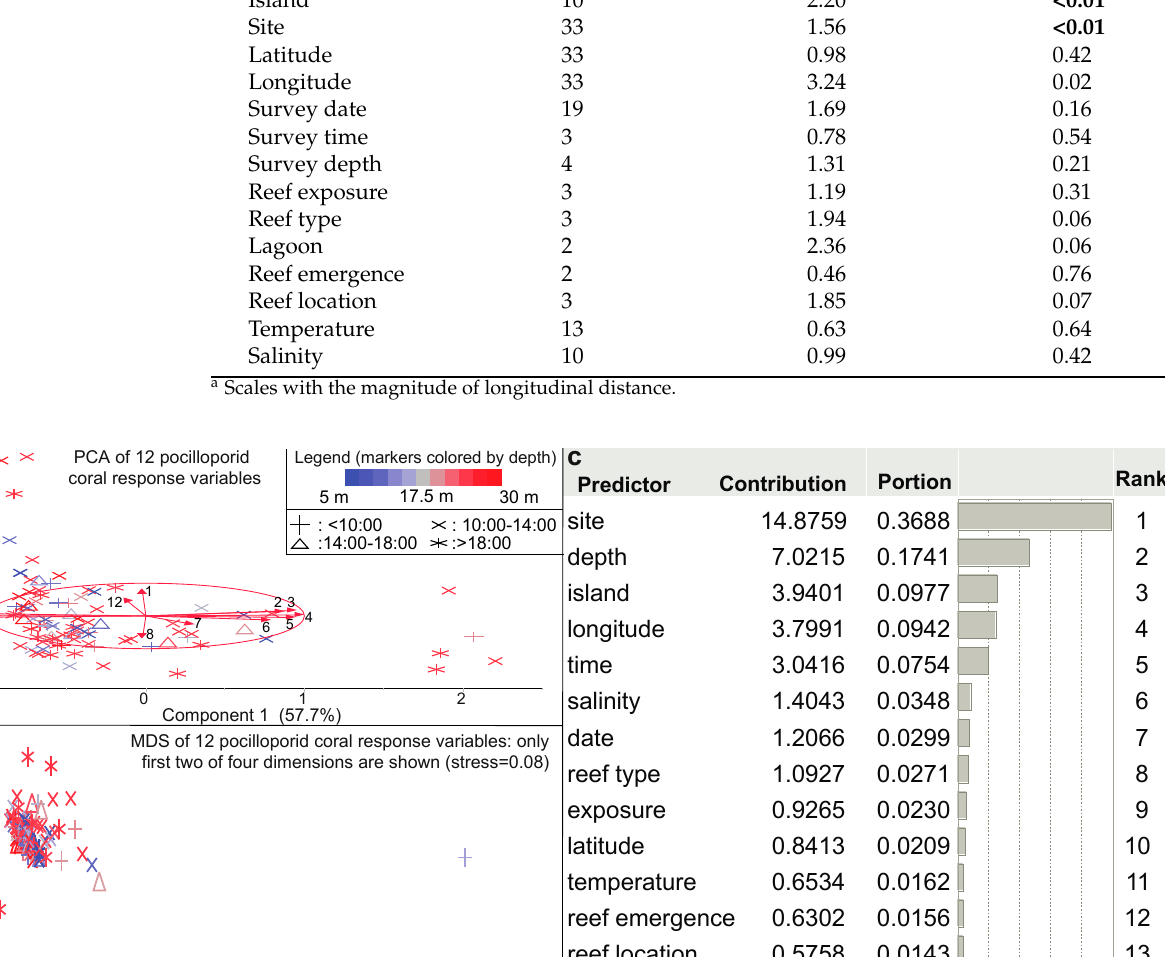
Table 2. Non-parametric multivariate ANOVA of the effects of the 14 environmental parameters on coral phenotype (as four-factor loading scores derived from a factor analysis of 16 coral physiological response variables). Statistically significant differences ( α = 0.01) have been highlighted in bold. n